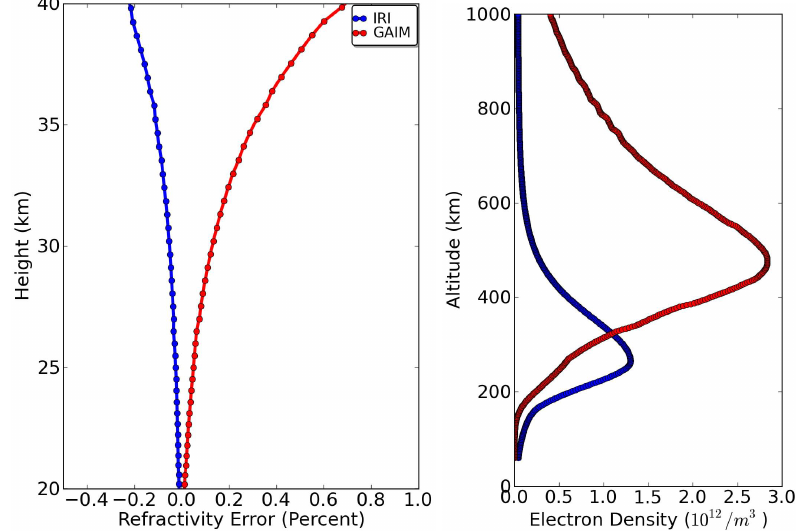
Fig. 12. Left panel: retrieval simulation results plotted as refractivity fractional error, for the IRI and GAIM cases. CHAMP satellite geometry is assumed. Right panel: vertical electron density profiles near the occultation tangent point.